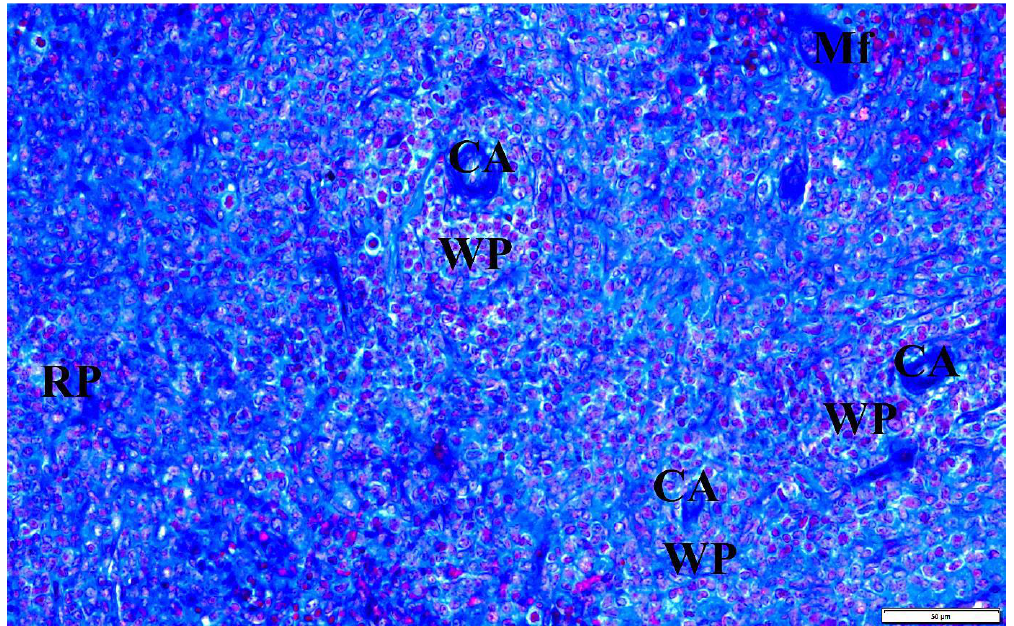
Figure 8. The spleen of a rat with transplacental infection with B. microti 3 weeks after birth. CA— central artery, Mf—macrophage, WP—lymphoid follicles (white pulp), RP—red pulp.